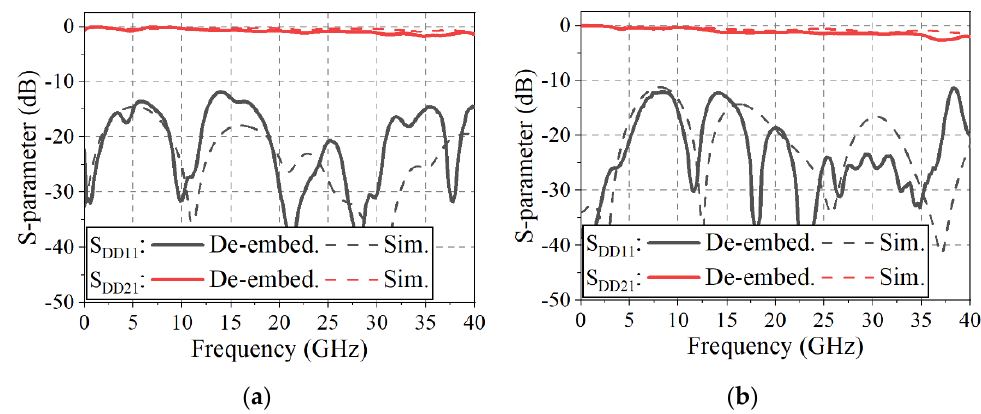
Figure 20. EM–simulated and measured S–parameters of the proposed transitions: ( a ) DL–to–CPS transition, ( b ) DL–to–PSL transition.